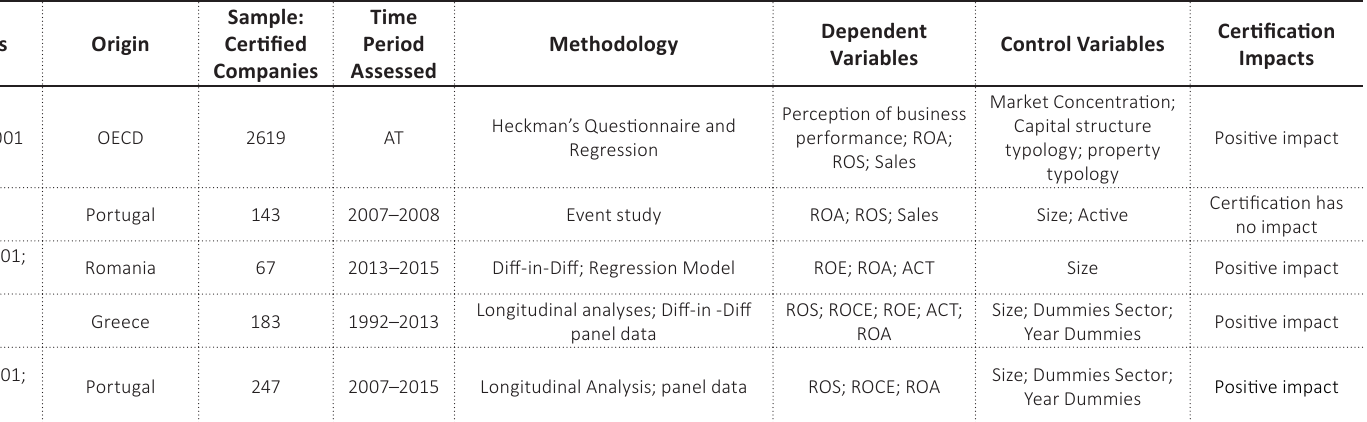
Table A1 (cont.). Empirical